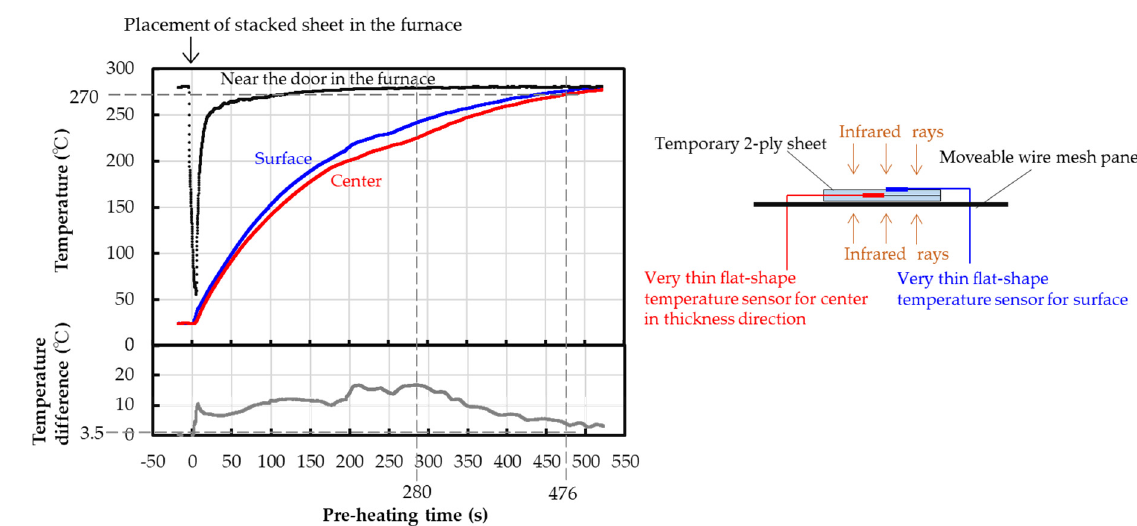
Figure 7. Prior measurement for temperature difference in the thickness direction of a temporary 2-ply sheet during pre-heating. The time when the sheet was placed on the wire mesh panel in the furnace was set to 0 s.